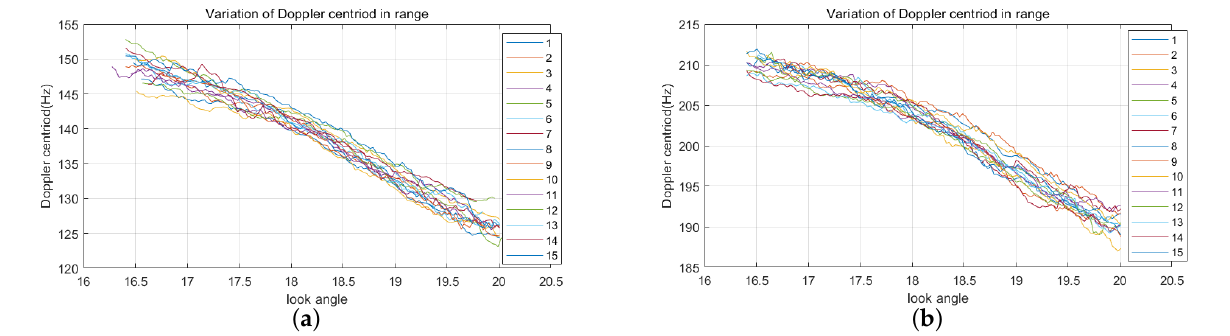
Figure 9. The relative change of the Doppler centroid in range. ( a ) The first set of GF-3 ATI data; ( b ) the second set of GF-3 ATI data.